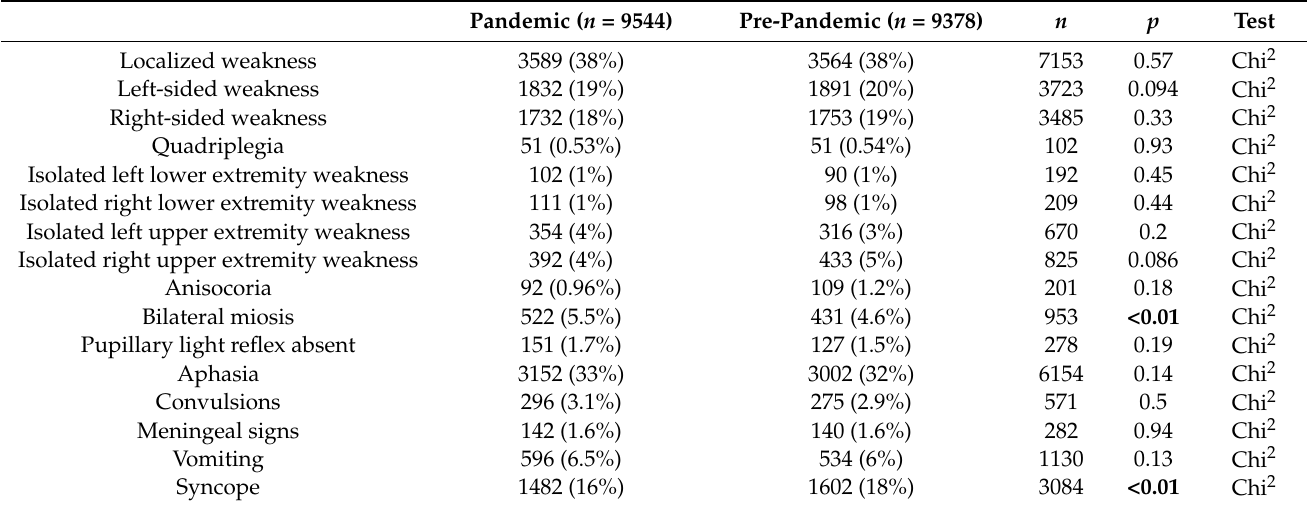
Table 6. Neurological